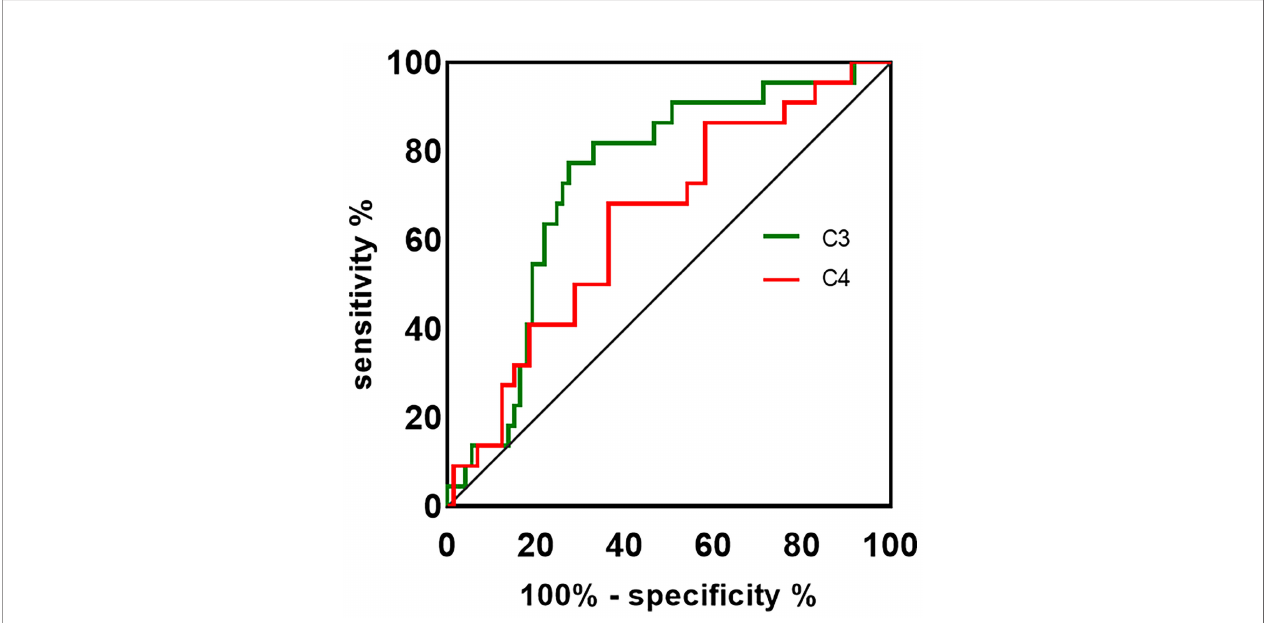
FIGURE 2 | The ROC curve is used to assess the discriminating ability of plasma C3, C4 in NMOSD and MOGAD. The AUC values showed the predictive power of the C3 (0.731) and C4 (0.645). ROC, receiver-operating characteristic; AUC, area under curve; C3, complement 3; C4, complement